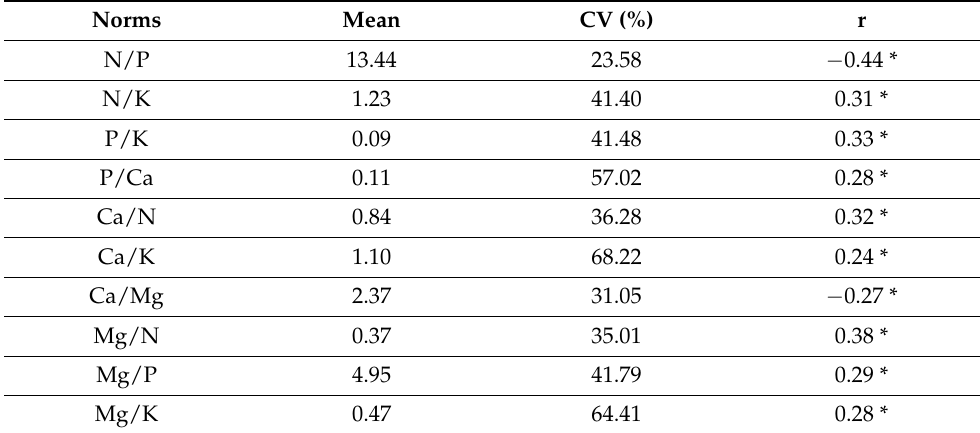
Table 1. DRIS norms (mean, CV, and correlation coefficient) in pepper crop in harvesting.